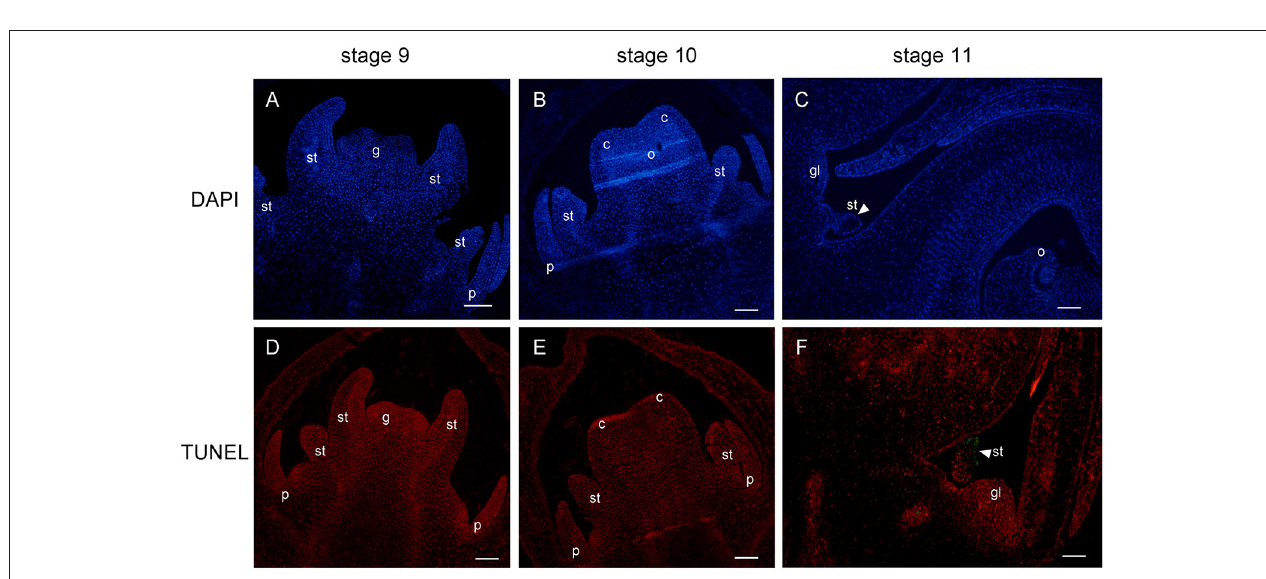
FIGURE 7 | DAPI staining and TUNEL assay of female flower at stages 9, 10, and 11. Staminode showed intact nuclei with bright DAPI at stages 9 (A) and 10 (B) . At stage 11, nuclear loss (arrowhead) was displayed in subepidermal staminode cells (C) . TUNEL signals were not detected at stages 9 (D) and 10 (E) , and were concentrated (arrowhead) in the staminode at stage 11 (F) . st, staminode; g, gynoecium; c, carpel; o, ovule; gl, gland. Scale bar = 100um.